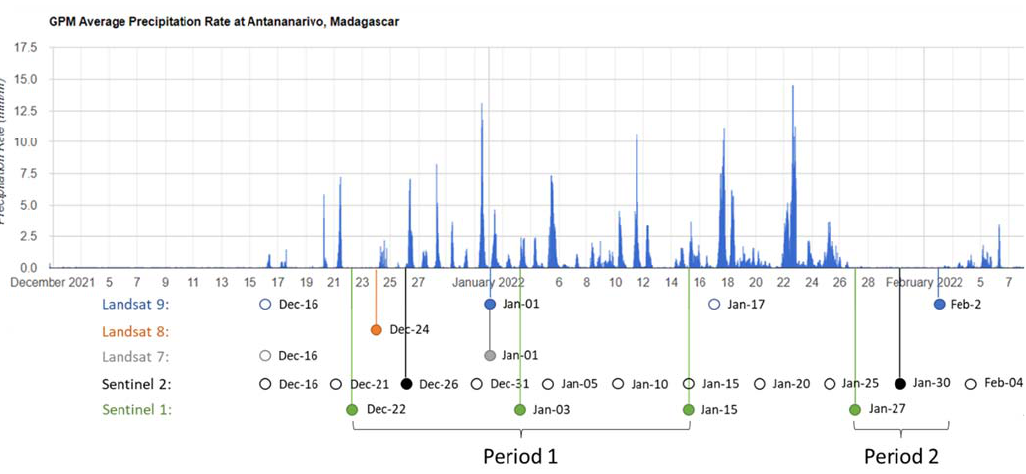
Figure 2. Time series of the rainfall intensity and satellite-available dates (solid dots show the images with lower cloud coverage used in the study) in the study area (rainfall data source: GPM). This study uses high ‐ resolution products from Landsat ‐ 7/8/9 and Sentinel ‐ 1 and ‐ 2 for spatiotemporal analysis of the surface water areas. All the NASA Landsat ‐ 7/8/9 multi ‐ spectral images provide visible and near ‐ infrared (VNIR), shortwave infrared (SWIR), thermal infrared (TIR), and quality assessment (QA) bands. This study uses the Green and SWIR bands to calculate the modified normalized difference water index (mNDWI) [46] to identify the water surface from the land surface. It is noted that the “strip” issue in Landsat ‐ 7 data was not addressed due to higher cloud coverage. All of the mNDWI layer was processed to 30 m spatial resolution. The QA band removes low ‐ quality observations such as clouds, cirrus, and cloud shadow to minimize their impacts on the water surface